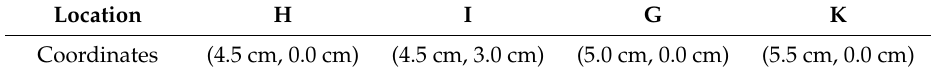
Table 5. The values of Johnson-Cook plasticity model parameters for steel in example 2.